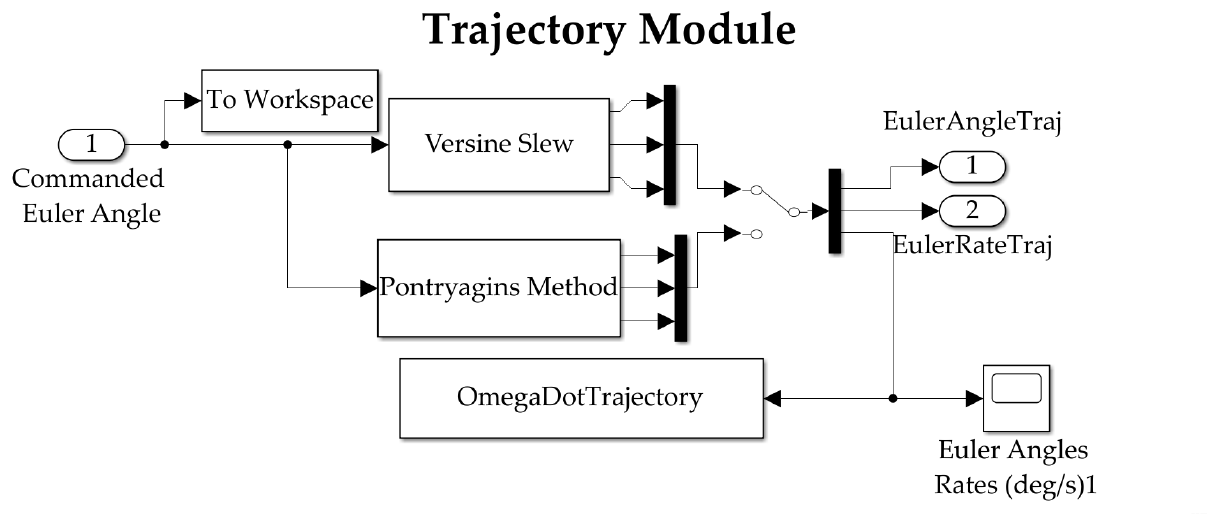
Figure A2. MatLab model with complete detailed display of the trajectory Simulink